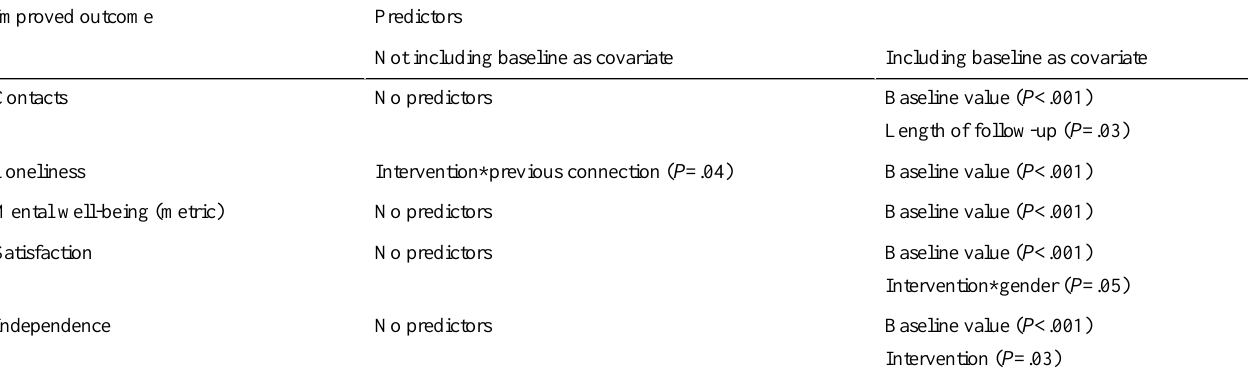
Table 3. Significant predictor variables in general linear models predicting improvement in five outcome variables.